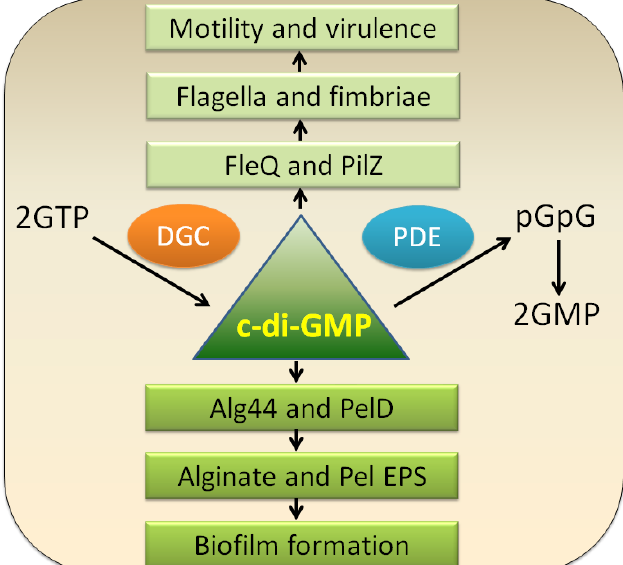
Figure 2. Schematic presentation of physiological functions of c-di-GMP. In bacterial cells, c-di-GMP is generated by diguanylate cyclases (DGC) and broken down by specific phosphodiesterases (PDE). As a second messenger, low levels of c-di-GMP can promote motility by upregulating flagellar expression, assembly or interfering with flagellar motor function and are required for the expression of acute virulence